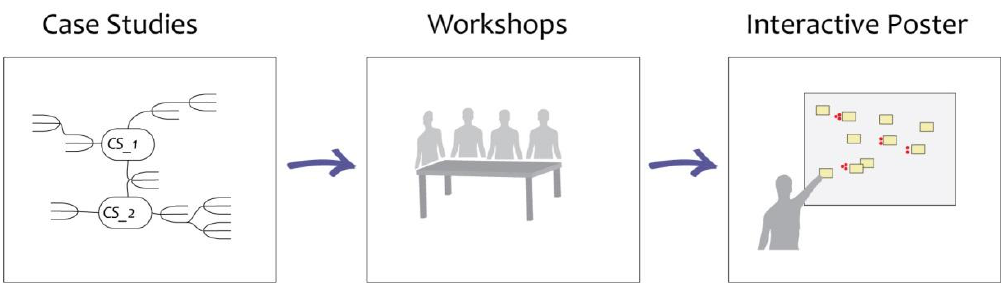
Figure 1. The methods used to derive the issues.